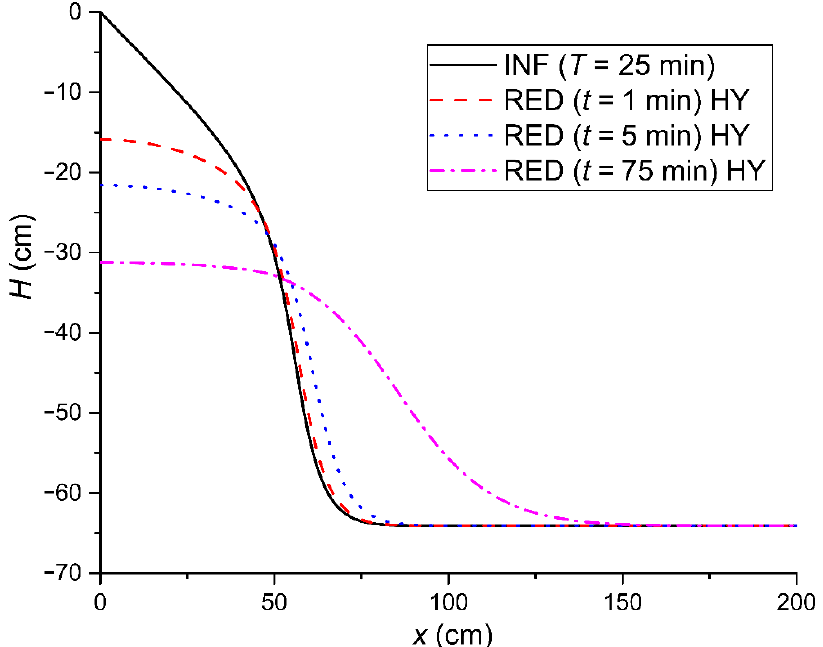
Figure 5. The relation between soil water pressure head H and horizontal distance x , H(x), after a horizontal infiltration (INF) with duration T = 25 min and during the redistribution (RED) process with the inclusion of hysteresis for time intervals t = 1, 5, and 75 min with initial water content θ o = 0.12 cm 3 cm − 3 ( H = − 64.1 cm) and using the boundary drying curve.